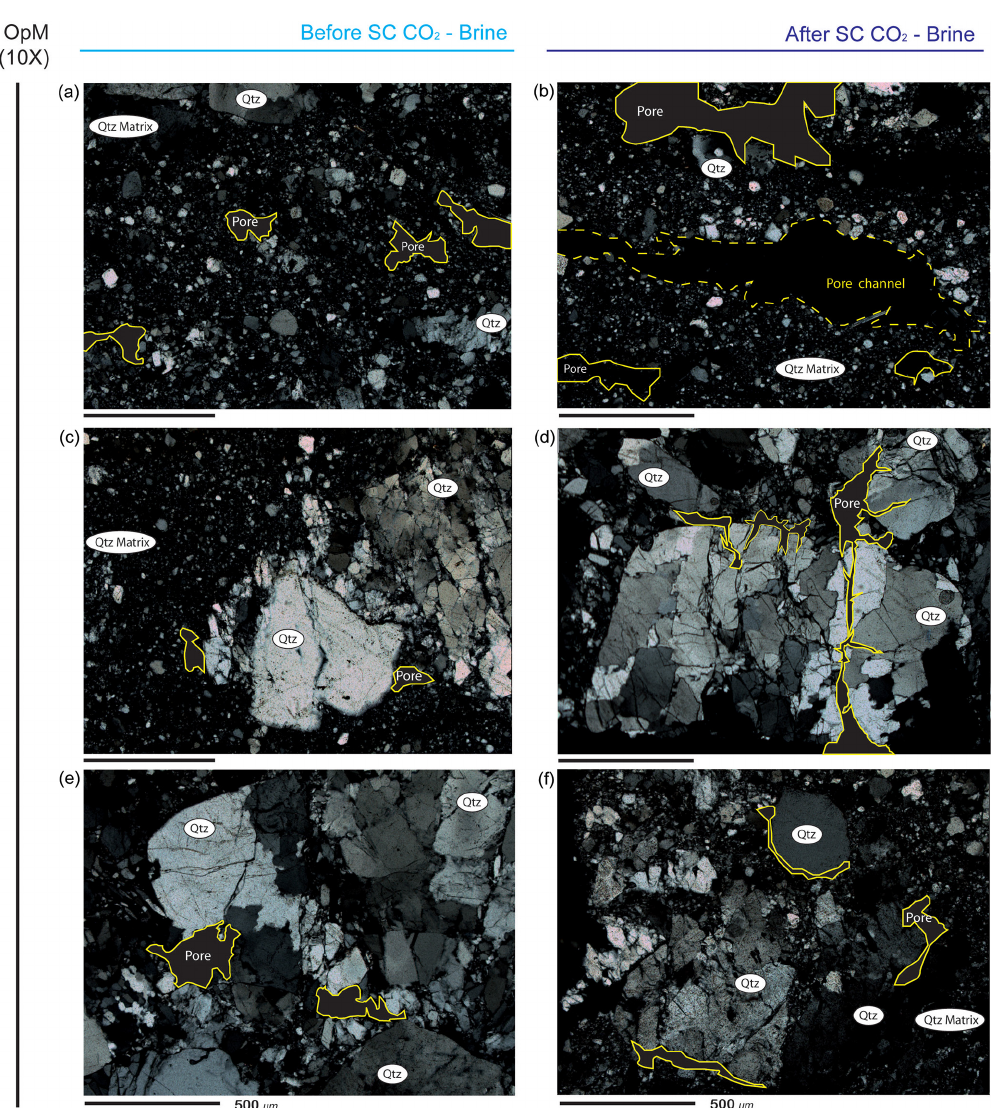
Figure 4. Textural and mineralogical characterization of the Utrillas sandstones. Optical microscopy images obtained under cross-polarized light conditions acquired using objective lens of 10 × . Left images (a, c and e) correspond to samples before SC CO 2 injection; showing the main textural and mineralogical features corresponding to quartz grains and sandy matrix and inter-crystalline pores within the matrix or in the vicinity of skeletal quartz grains. Right images b, d and f) correspond to samples after SC CO 2 injection; showing no changes in the mineralogical features and a pore network characterized by the presence of channels, caverns and pores within large quartz grains.